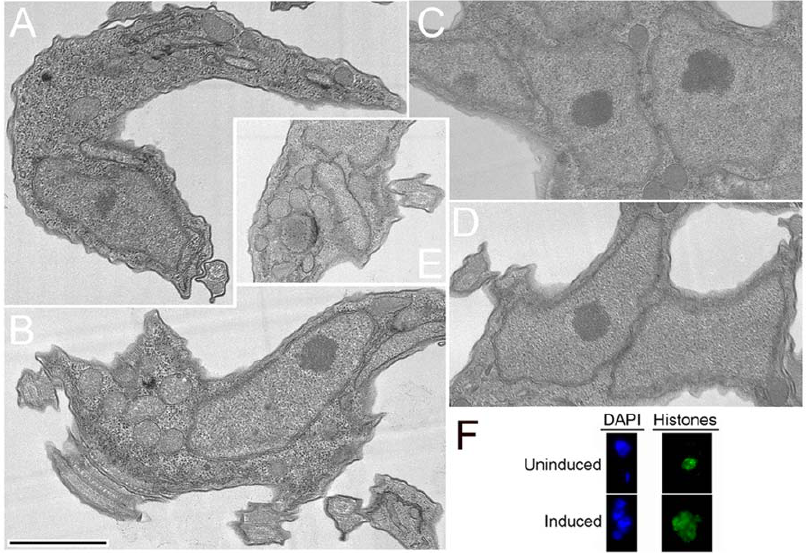
Figure 5. Nuclear architecture and chromatin appear normal in BSF cells depleted of TbRHP. (A–D) BSF parasites were induced for TbRHP RNAi for 24 hours and then fixed and processed for transmission electron microscopy. (A–D) Cells exhibited apparently normal nuclear architecture, including the double membrane nuclear envelope, nuclear matrix and nuceolus flagellar profile (A) and (B), normal spacing for the subpellicular microtubule array, and the absence of any obvious gross abnormalities. (E) some membranous structures are visible, which resemble accumulated membrane and possibly multi-vesicular bodies. These structures are rare and not seen in all cells. Bar, 1 m m. (F) Immunofluorescence analysis of histone and DNA distruibution. Anti-histone H3 antibody was used to highlight histones (green) and DAPI was used to visualize DNA (blue) in uninduced and induced cells. Representative images are shown.